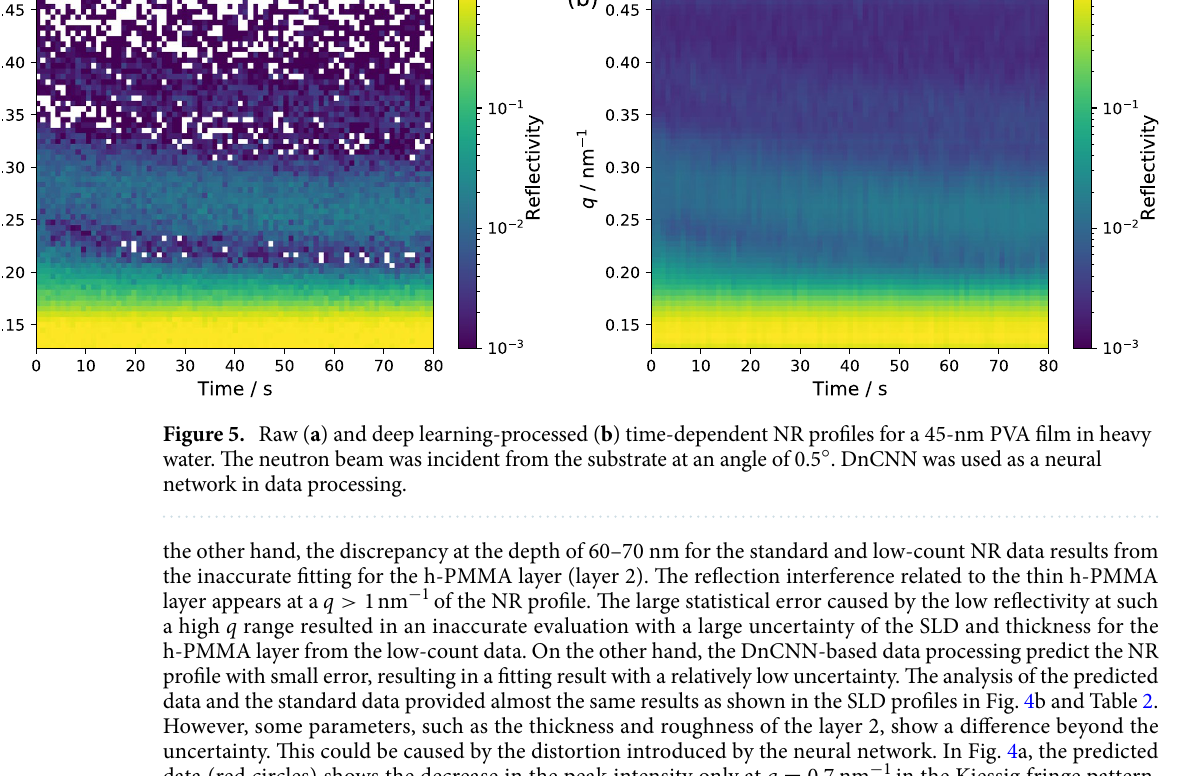
◦ . DnCNN was used as a neural